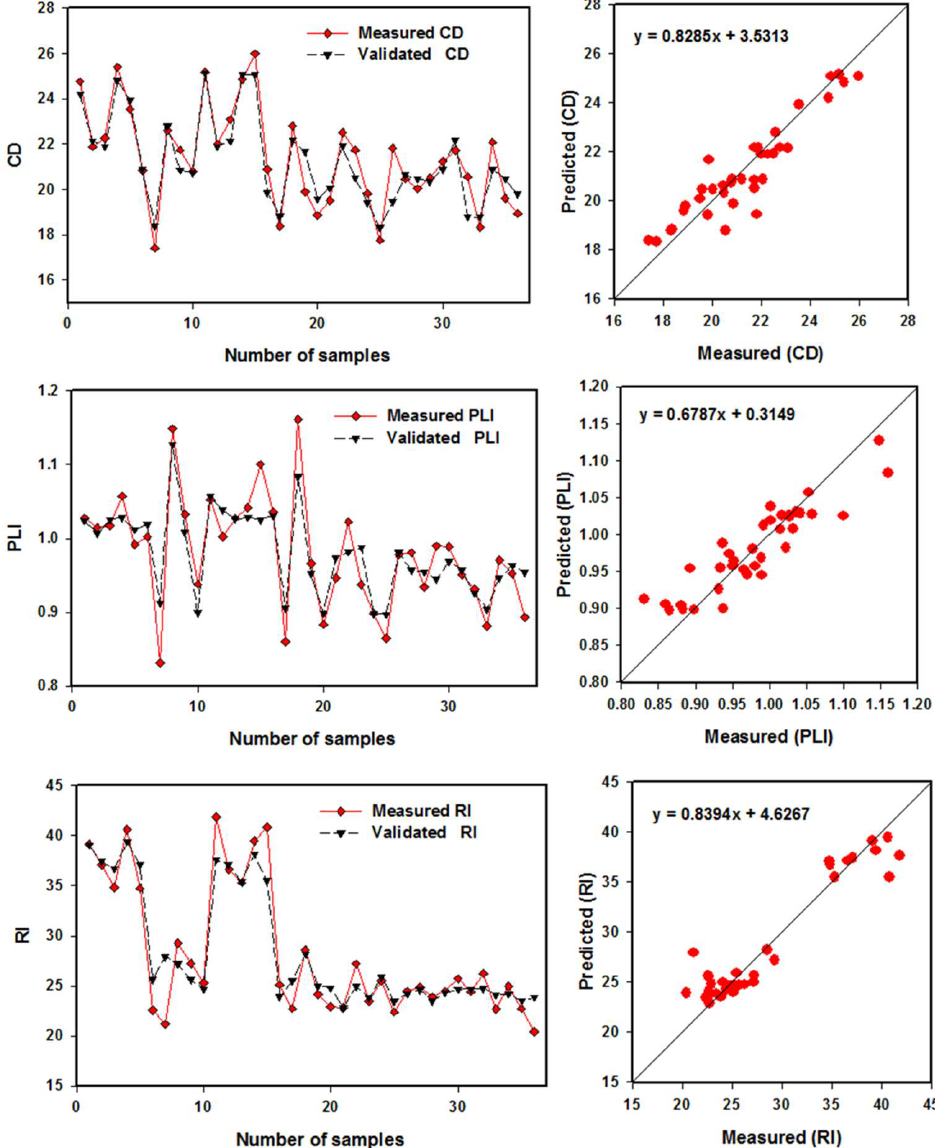
Figure 4. Comparison between measuring datasets, and validating datasets pollution load index (PLI), contamination (CD), and potential ecological risk index (R1) in two years using the RF models dependent on several elements.